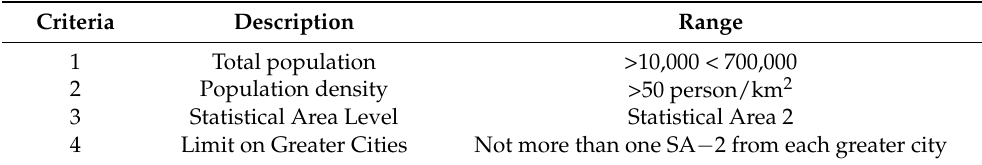
Table 1. Selection criteria for the comparison of Australian